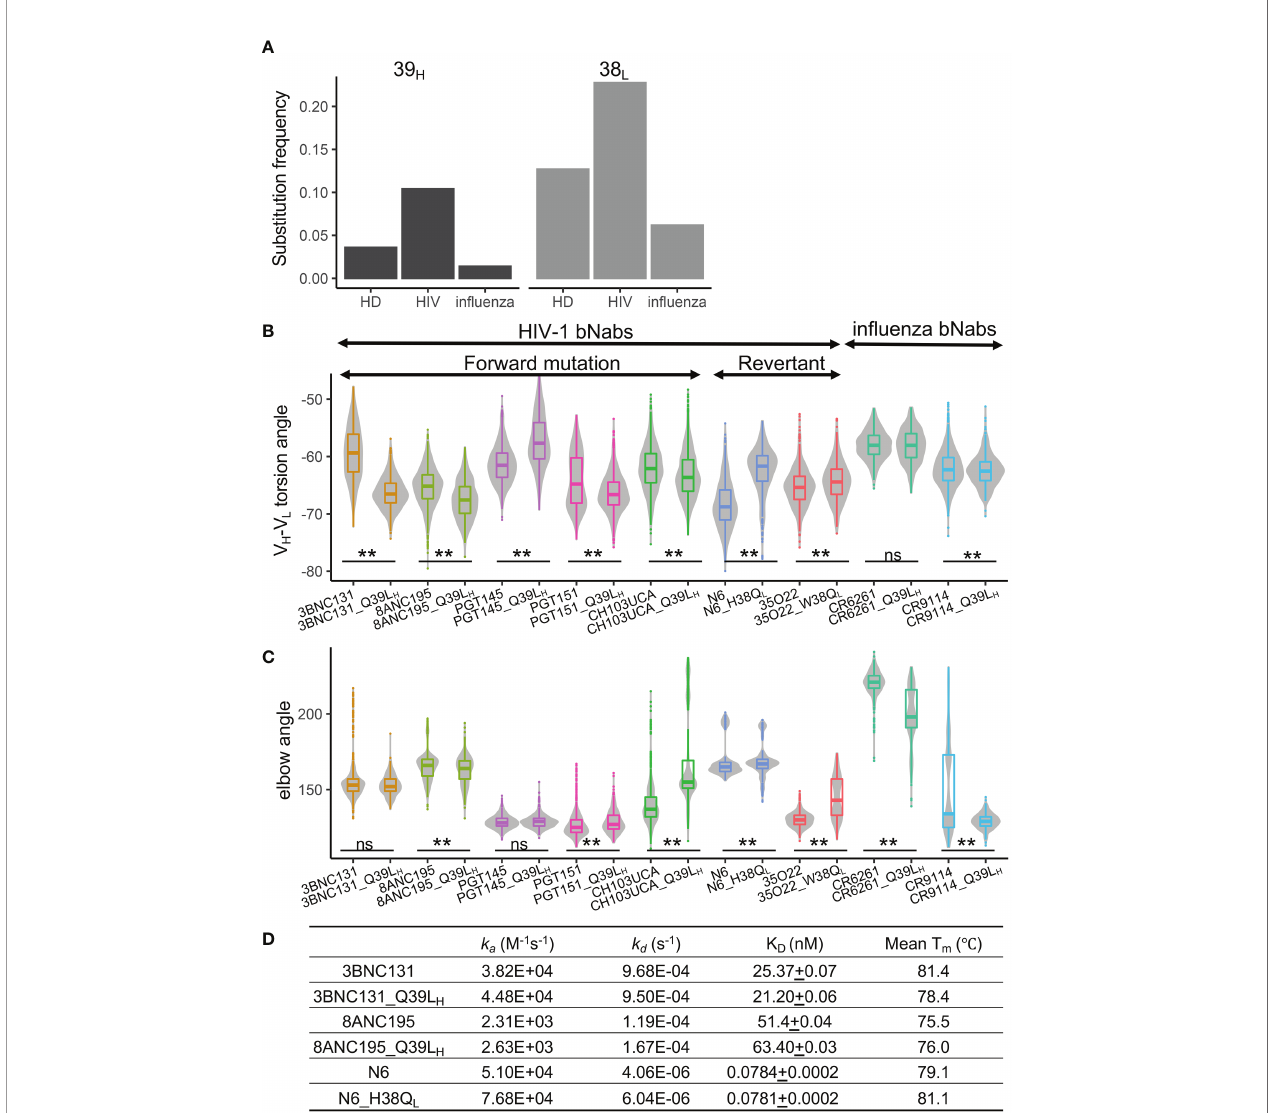
FIGURE 6 | Somatic hypermutations at 39 H and 38 L are enriched in anti-HIV-1 antibodies. (A) Frequencies of somatic hypermutations at 39 H and 38 L increase in anti-HIV-1 antibodies. HD, healthy donor antibody repertoire. (B) Somatic hypermutations at 39 H and 38 L modulate the V H -V L conformation of bnAbs. (C) Somatic hypermutations at 39 H and 38 L modulate the elbow conformation of HIV-1 and in fl uenza bnAbs. P values less than 0.01 are labeled with two stars. ns, not signi fi cant. We use Bonferroni Correction to control false discover rate of multiple test <0.01. (D) Somatic hypermutations at 39H and 38L do not affect the binding af fi nity of three HIV-1